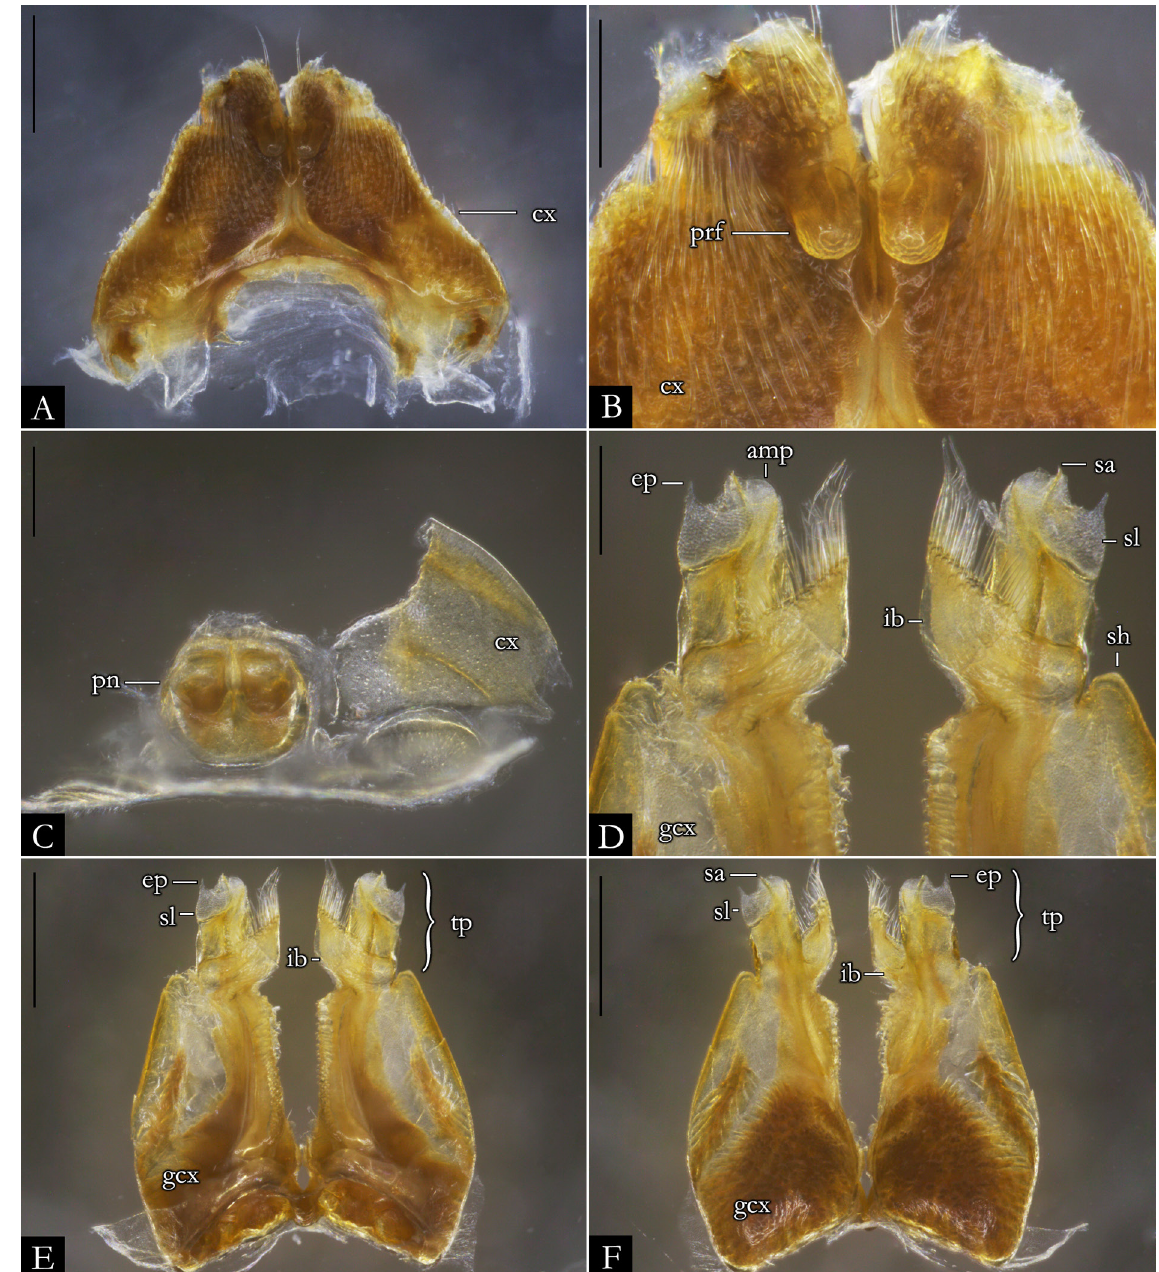
Fig. 65. Pseudonannolene curtipes Schubart, 1960, paratype. ♂ (MZSP 1027). A . First leg-pair. B . Detail of prefemur. C . Second leg-pair. D . Detail of telopodites, in anal view. E . Gonopods, in anal view. F . Gonopods, in oral view. Abbreviations: see Material and methods. Scale bars: A, E–F = 0.5 mm; B–D = 0.2